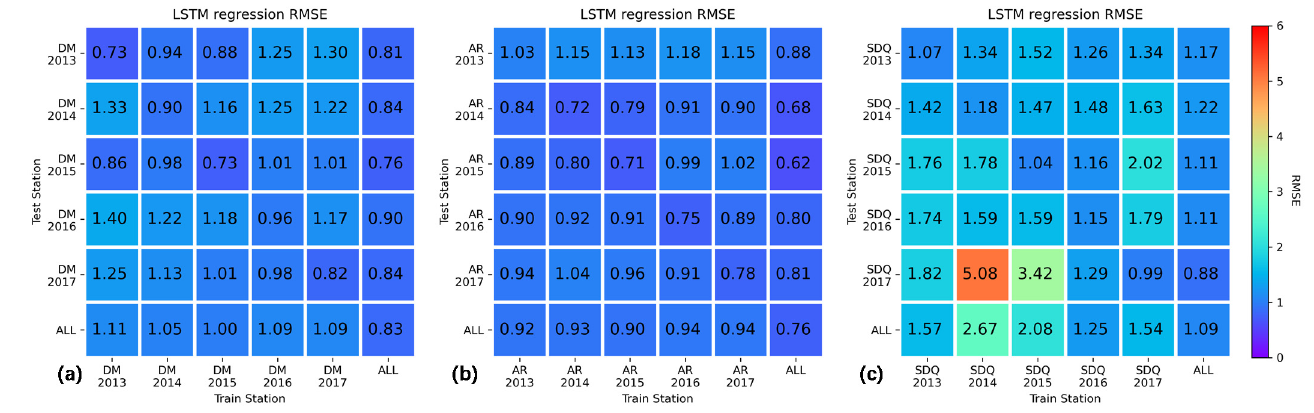
Figure 10. The RMSEs of predicted results by LSTM regression method using training and test data from same stations during different years. ( a – c ) correspond to DM, AR, and SDQ stations, respec-